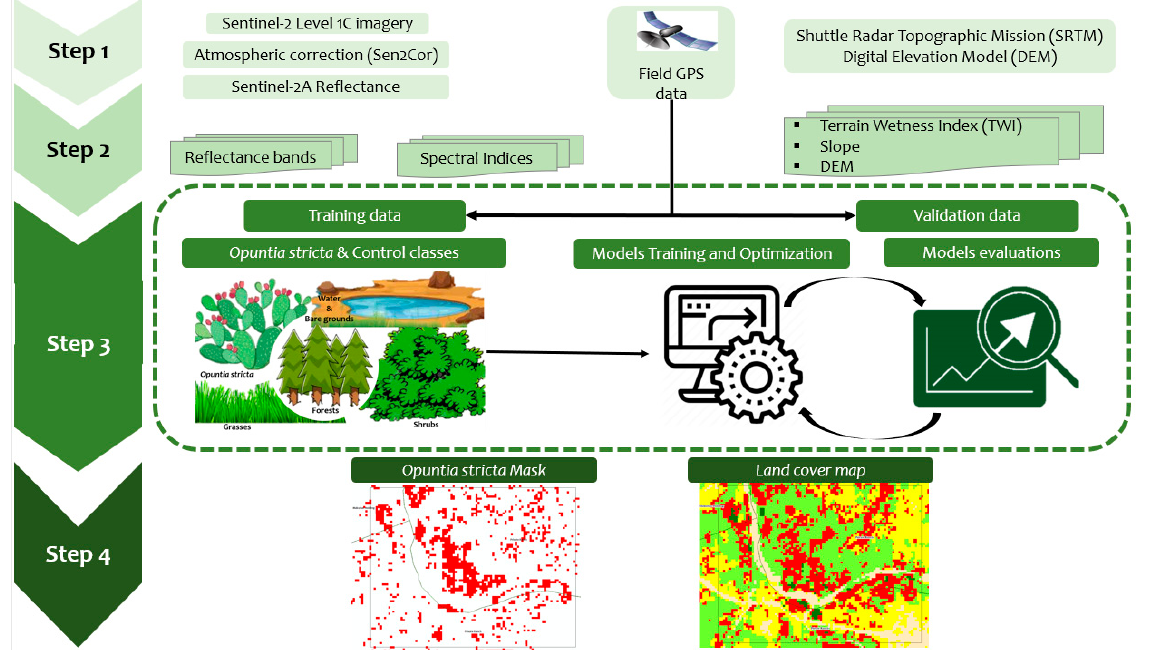
Figure 1. Methodology flow chart.